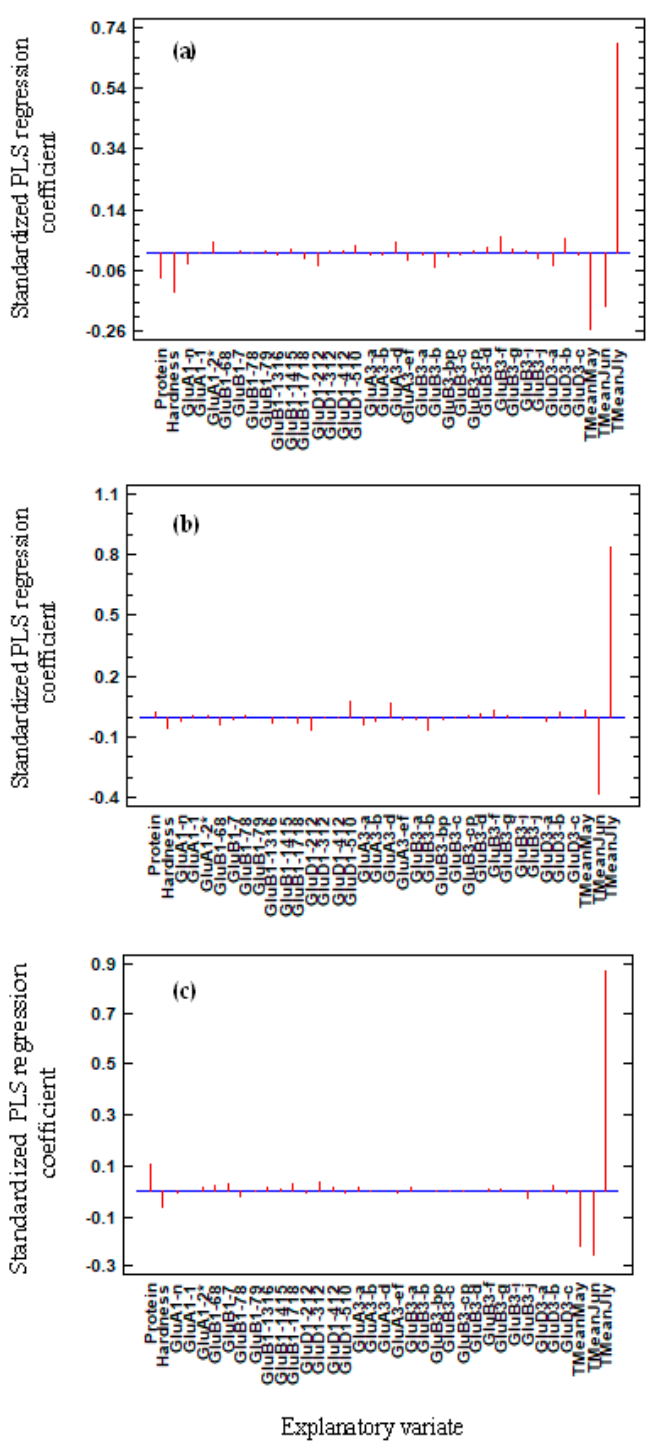
Figure 1. Standardized coe ffi cients of the partial least square (PLS) regressions, explaining the molecular mass (Mw) ( a ), gyration radius (Rw) ( b ), and polydispersity index (PI) = Mw / Mn ( c ) characteristics of the polymers. The grain protein concentration (PC) (noted Protein) and grain hardness (GH) (noted Hardness) were explanatory variates first introduced in regression, followed by 14 alleles of high molecular weight glutenin subunits (HMW-GS); 17 alleles of low molecular weight glutenin subunits (LMW-GS); and the average temperatures of May, June, and July (noted Tmean May, Tmean June, and Tmean